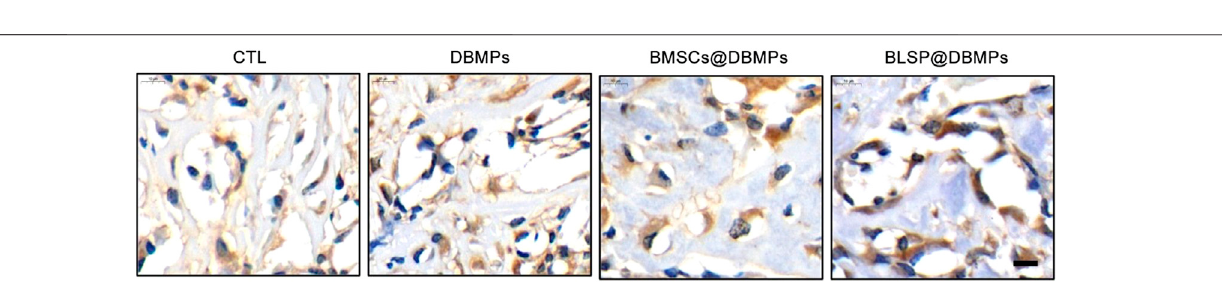
Frontiers in Cell and Developmental Biology |